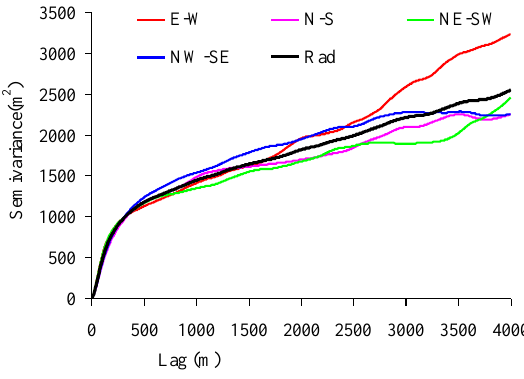
Figure 2. Semi-variograms from the four principal directions calculated based on Hc-DEM2.5 m.